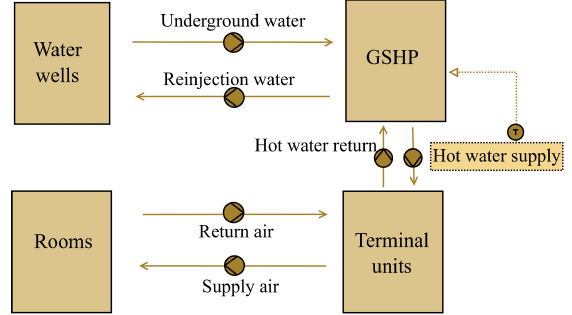
Figure 3. Schematic diagram of the ground source heat pump (GSHP) system.